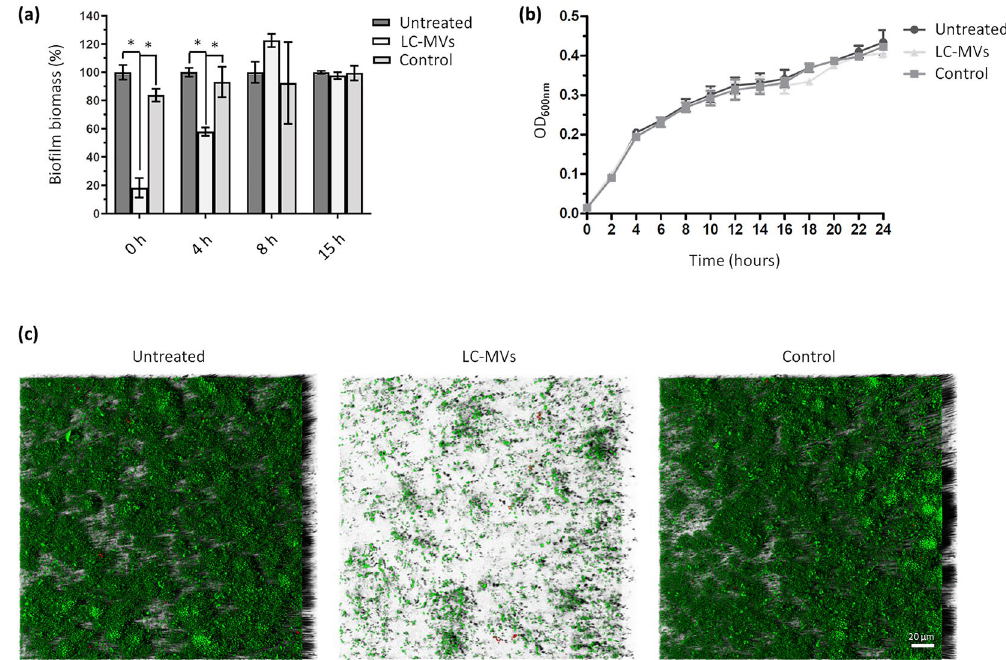
Figure 3. Membrane vesicles released by L. casei BL23 (LC-MVs) inhibit the early stages of biofilm formation without impacting the growth of S . Enteritidis. ( a ) S . Enteritidis was grown in polystyrene microplates and treated with LC-MVs (0.04 µg/µL) or a control fraction after 0, 4, 8 and 15 h of growth. After 24 h of culture, biofilms were quantified by crystal violet staining. The control corresponds to the fraction collected after carrying out the purification protocol on the culture medium alone (i.e., MRS medium). Results were normalized to the untreated conditions and expressed as a percentage. ( b ) Comparison of S . Enteritidis growth curves in the absence and in the presence of treatment with LC-MVs (0.04 µg/µL) and the control fraction. ( c ) The biofilms formed by S . Enteritidis after 24 h of culture in the absence or in the presence of treatment with LC-MVs (0.04 µg/µl) were stained (live/dead; SYTO 9/propidium iodide) and imaged by confocal laser scanning microscopy (CLSM). Green: total biomass. Red: dead cells.